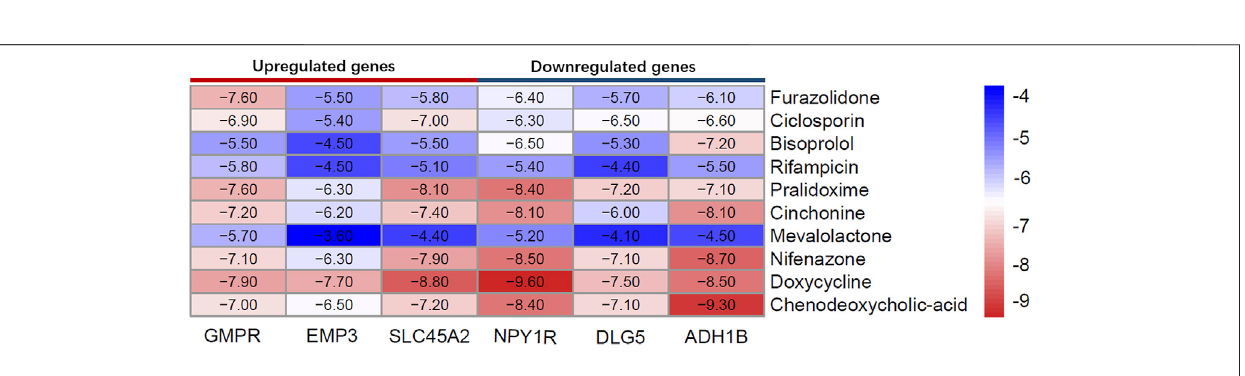
FIGURE 11 | Heat map of the lowest binding energy for molecular docking.